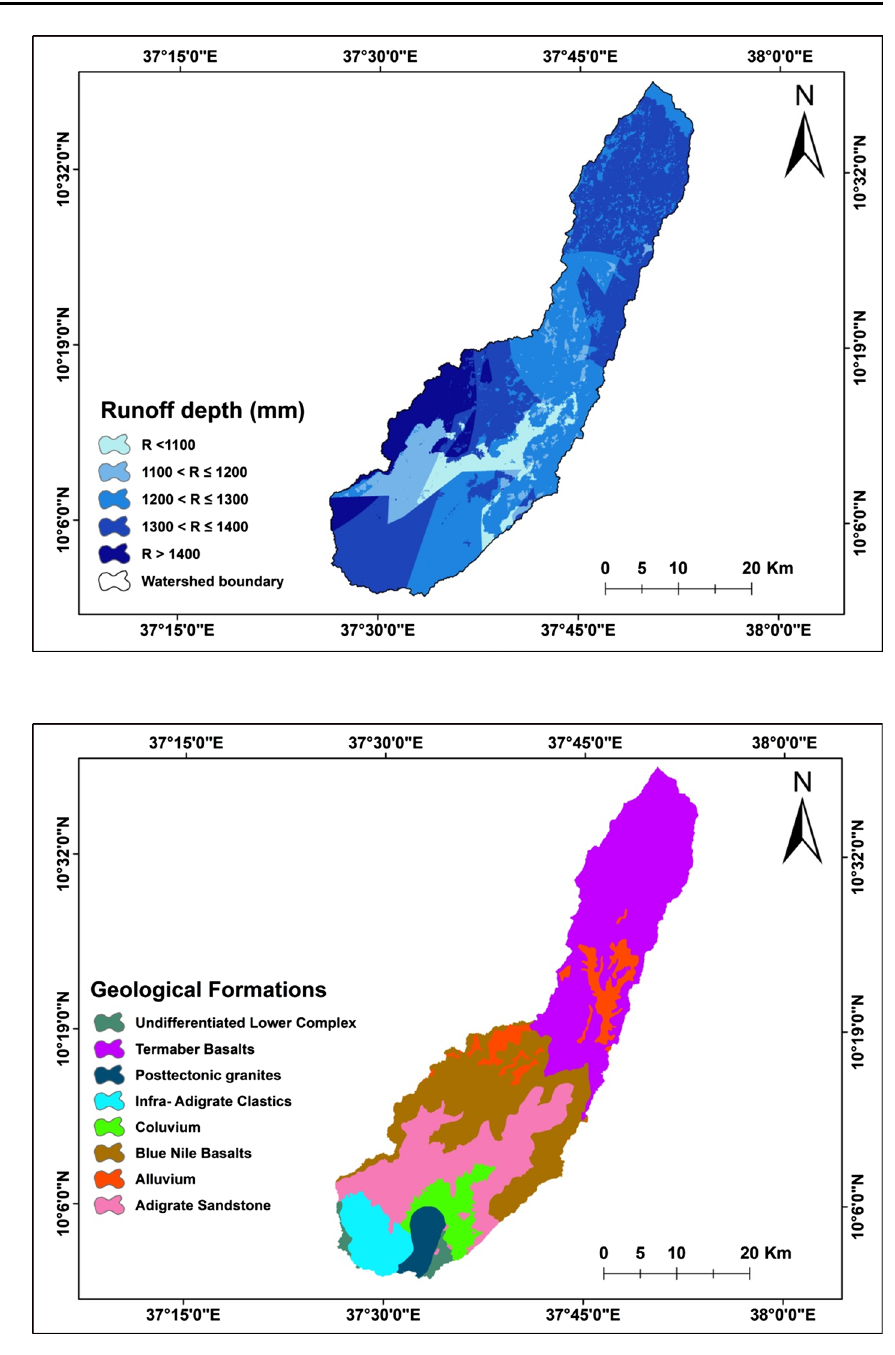
Fig. 8 Runoff depth map of the study area